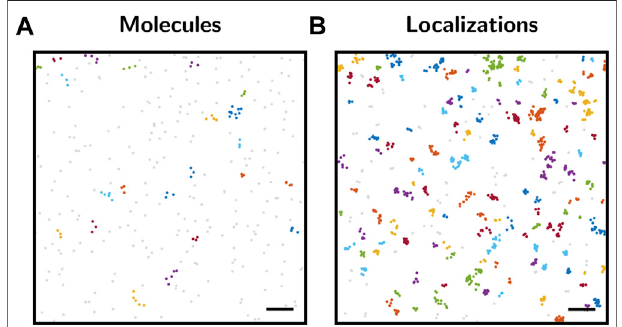
FIGURE 1 | Cluster analysis with DBSCAN. (A) Map of molecule positions. Positions were generated by a spatial Poisson point process with a density of 80 points per μ m 2 . The point pattern was analyzed by DBSCAN (Ester et al., 1996). Analysis parameters were set to r = 50 nm for the search radius and n = 3 for the minimum number of points constituting a cluster.Thecolorcode represents thecluster assignment. Unclustered points are shown in gray. Although the molecule point pattern represents complete spatial randomness, 22 clusters were identi fi ed by DBSCAN. (B) SMLM localization map simulated based on the molecule positions from panel (A) , including overcounting according to the blinking statistics of SNAP-AF647 (Arnold et al., 2020). The localization map was analyzed by DBSCAN as described in panel (A) , yielding 116 clusters. Scale bars: 200